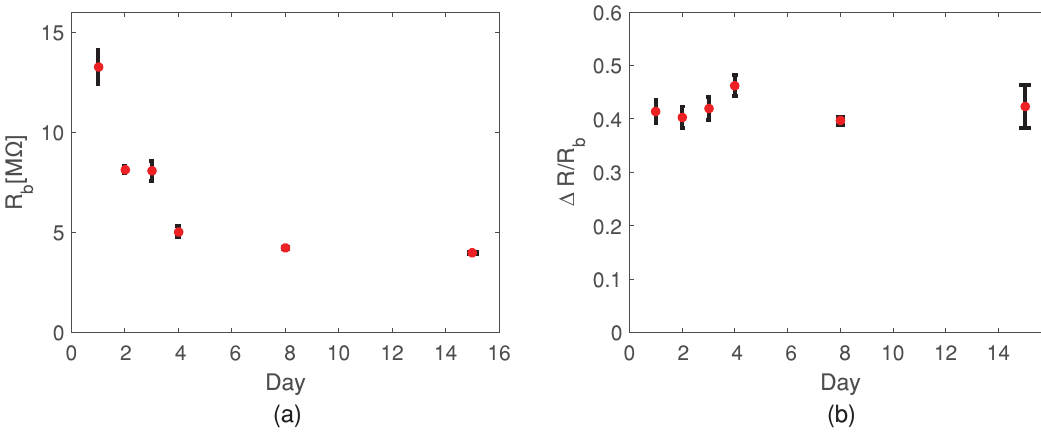
Figure 5. ( a ) Baseline resistance of sensor over time period of two weeks; ( b ) sensor response over time period of two weeks for NO concentration of 200